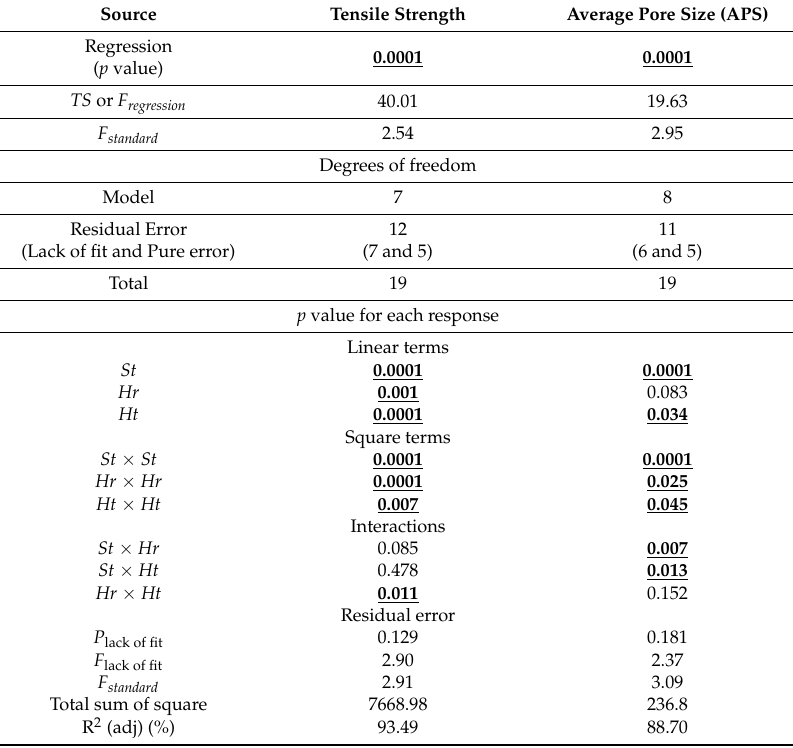
Figure 2. Main effect plots showing the effect of process parameters on the tensile strength: ( a ) Tensile strength versus temperature; ( b ) tensile strength versus heating rate; ( c ) tensile strength versus holding time; and ( d ) percentage contribution of each process parameter into the process. Table 2. Analysis of variance on the response of tensile strength and pore